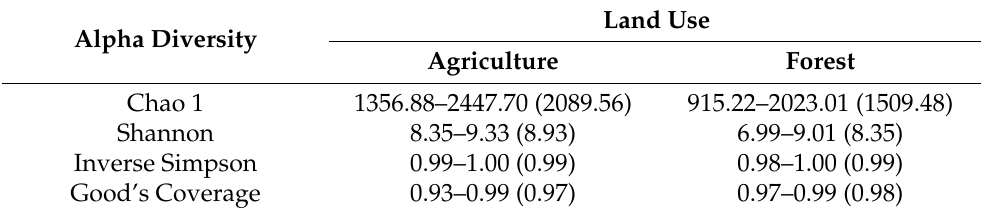
Table 2. Alpha diversity index of agriculture and forest